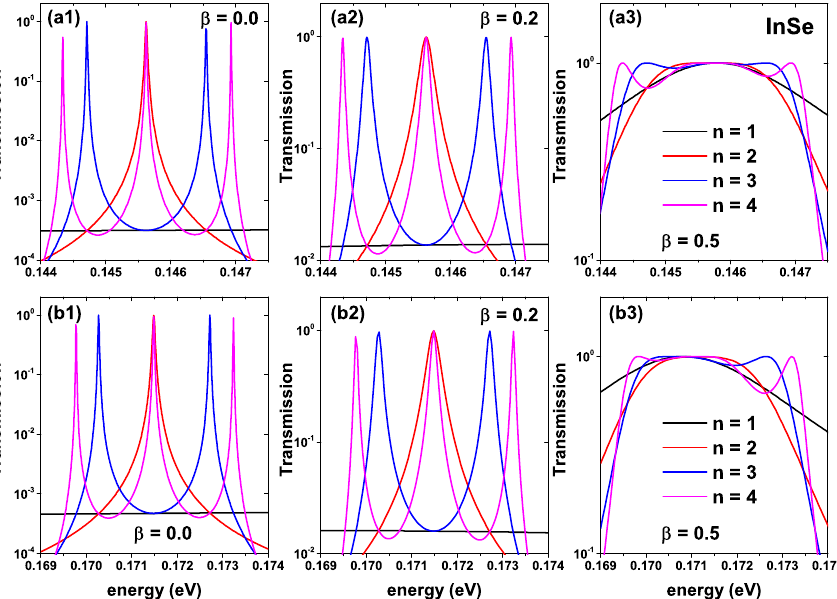
Figure 4. Energy dependence of the electronic transmission probabilities for an InSe-InP finite lattice, according to Figure 2, i.e., varying the n -number of periods and the shape according to the structural β -parameter. Results are without ILF effects (upper panels) and with α 0 = 1nm (lower panels). In ( a1 ), α 0 = 0nm and β = 0.0. In ( a2 ), α 0 = 0nm and β = 0.2. In ( a3 ), α 0 = 0nm and β = 0.5. In ( b1 ), α 0 = 1nm and β = 0.0. In ( b2 ), α 0 = 1nm and β = 0.2. In ( b3 ), α 0 = 1nm and β =